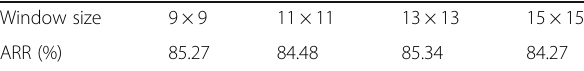
Table 5 Performance of the proposed method with various window sizes on Virus database Window size